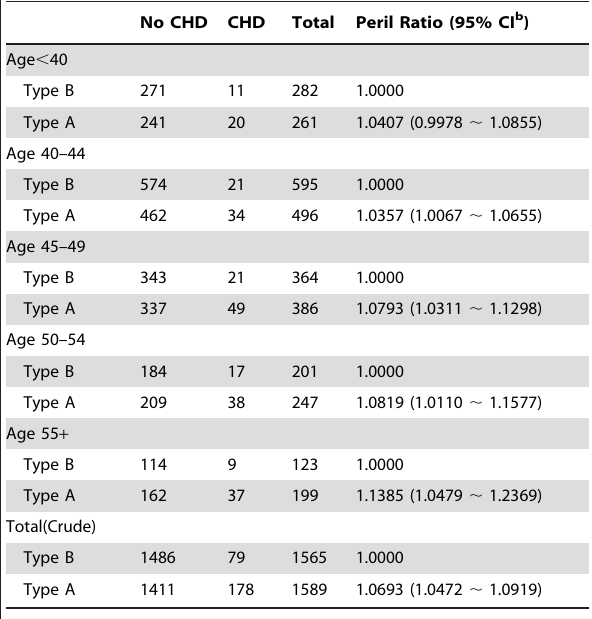
a from Table 7–24 in Selvin S (1991) Statistical Analysis of Epidemiologic Data. New York: Oxford University Press. b CI: confidence interval.